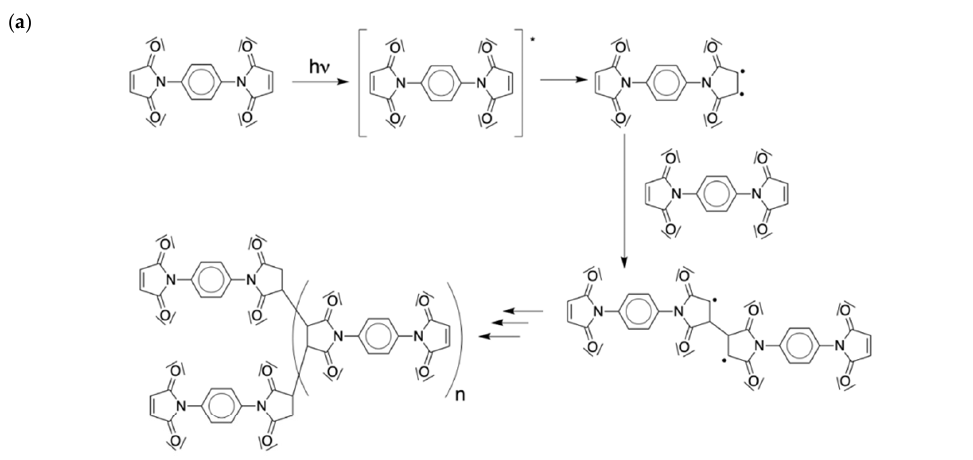
Figure 9. ( a ) Chemical pathway for the light-induced polymerization of N,N ′ -(1,4-phenylene)di- maleimide into a poly(N-substituted)dimaleimide chains. ( b ) AFM image (1000 × 1000 nm 2 ) of a long fibres of poly(N-substituted)dimaleimide on a KCl(001) surface. ( c ) Zoom of ( b ) (20 × 10 nm 2 ) showing a zig-zag structure. This reflects a topological rumpling of the fiber due to a coincidence of every fifth molecule with the fourth cation along the KCl(001) crystal axis. 3. Conclusions On-surface synthesis provides new possibilities to form highly stable and atomically defined nano-structures that exhibit desired electronic, optical, catalytic, and other prop- erties. The spatial confinement of on-surface reactions gives access to entirely new reac- tion pathways and allows to guide the size, the shape, and the nature of the formed struc- tures. The challenge one has to accept to overcome the limitations of low quality (exten- sion and number of defects) and inhibited functionalities when using metal substrates is complex. A simple transition of the already well-known reactions which work on metal substrates to passivated substrates is impossible since, on passivated substrates, the cata- lytic effect of the metal substrate is absent, and the relatively high annealing temperatures applicable to metals cannot be used on passivated substrates due to the relatively low molecule-substrate interaction, which results in the desorption of molecules instead of the bond formation. Therefore, many outstanding results have been recently obtained in the field of on-surface chemistry onto inert surfaces. Covalently bonded nanostructures are accessible by combining the smart design of precursors and external stimuli (light, elec- trons, and annealing) for each type of passivated surface. Furthermore, the development of new analytical methods to fully describe on-surface reactions could be a possible route for advancing the field in the future. Indeed, despite their ability to resolve internal bonding structures, the bottleneck to fully characterizing the on-surface reactions is that STM or AFM are chemically insensitive. To overcome this lack of information, techniques such as infrared (IR) coupled with the AFM and Tip-En- hanced Raman Spectroscopy (TERS) to perform Raman spectroscopy on the nanometer scale could greatly improve on-surface chemistry studies in UHV in the upcoming